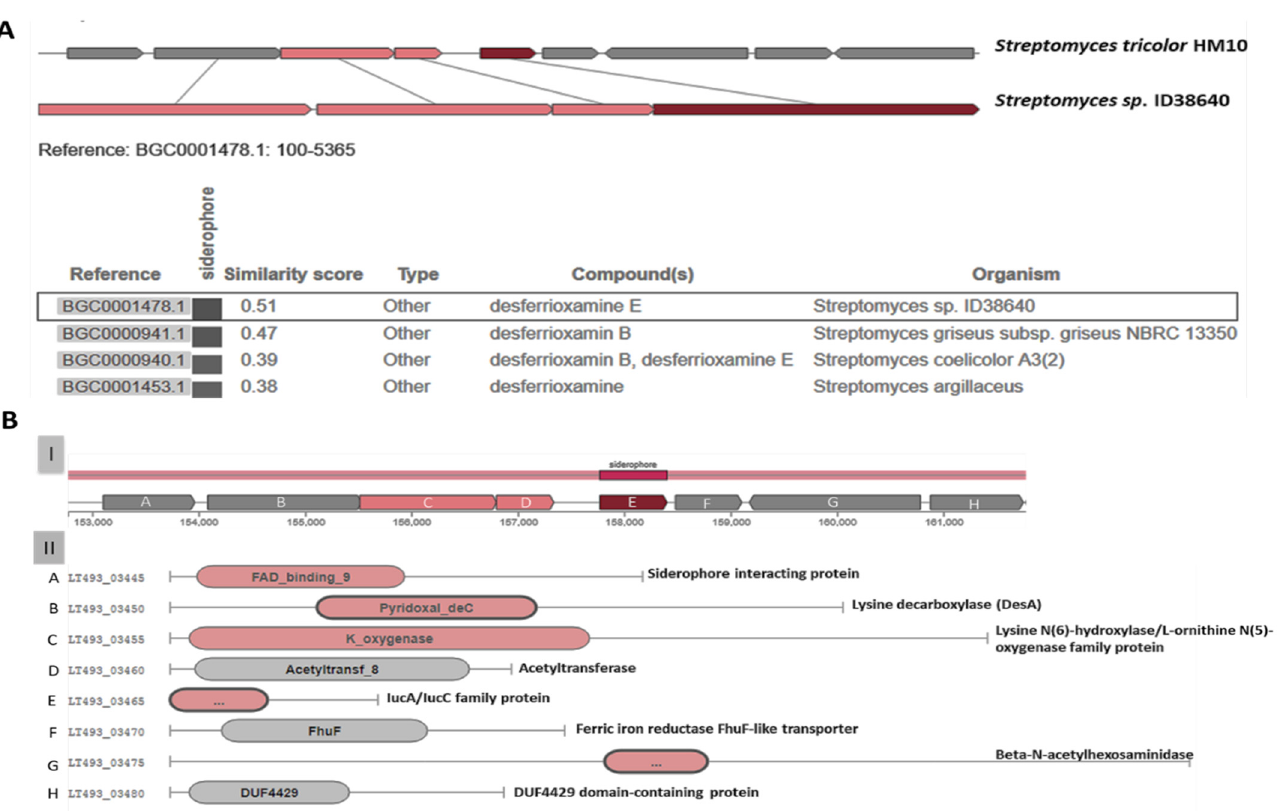
Figure 4. ( A ) The comparison between the proposed hydroximate-type siderophore gene cluster (dark red and orange genes) in S. tricolor HM10 and the identified hydroximate desferrioxamine B/E siderophore from Streptomyces sp. ID38640 and S. griseus , with similarity scores of 0.51 and 0.47, respectively, on the MIBiG website. ( B ) The proposed hydroximate gene cluster in S. tricolor HM10